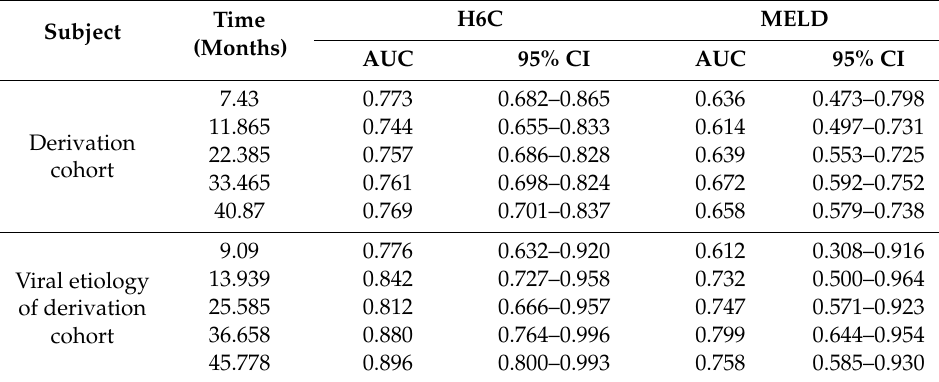
Figure 3. The cumulative survival rates according to the H6C score in patients with viral etiology. Patients with a low H6C score (shown as a continuous line) showed significantly higher survival rate than those with a high H6C score (shown as a dashed line). Table 3. Estimated time-dependent AUC of the H6C score and the